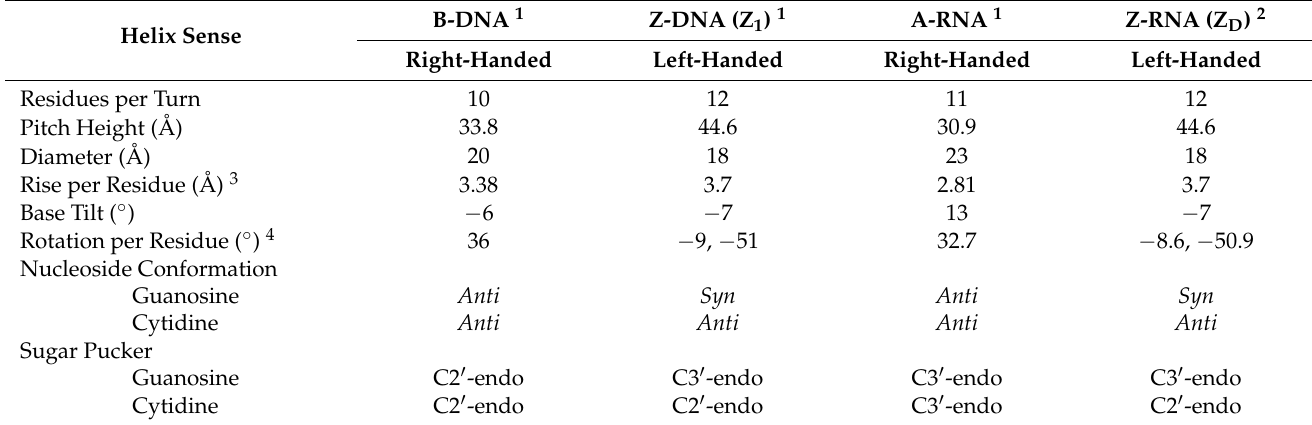
the Z-conformations; 4 The two values reported for Z-conformation nucleic acids are for the CpG and GpC steps,